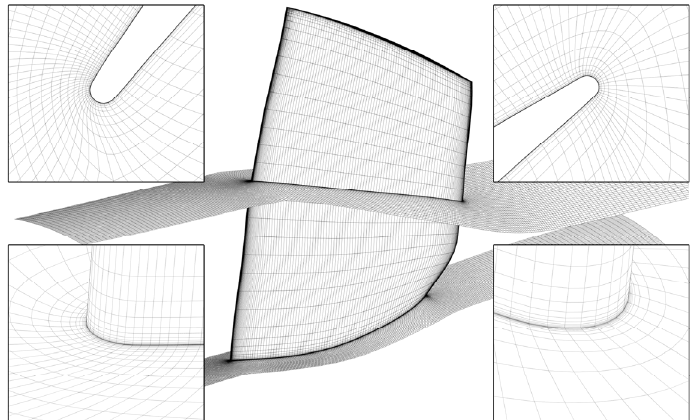
Figure 2. The multiblock structured O–H grid with 1.2 M nodes.